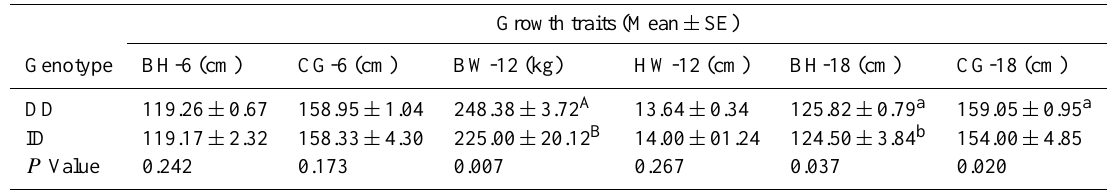
Table 4. Association of 17 bp indel within the SMAD3 gene and growth traits of CY cattle.